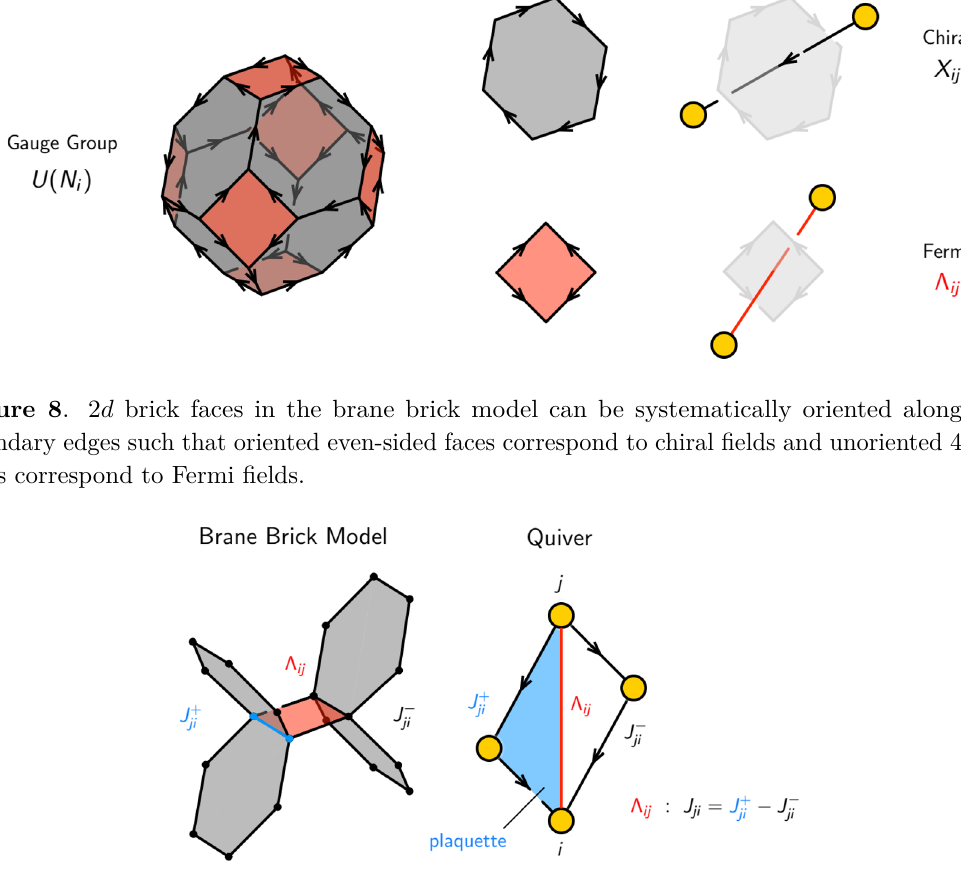
Figure 9 . Edges in the brane brick model correspond to monomials in the J - and E -terms of the 2 d theory. The corresponding collection of chiral fields with the associated Fermi field forms what we call a plaquette (blue). Each Fermi face with its four edges is associated with four plaquettes that form the J - and E -terms corresponding to the Fermi